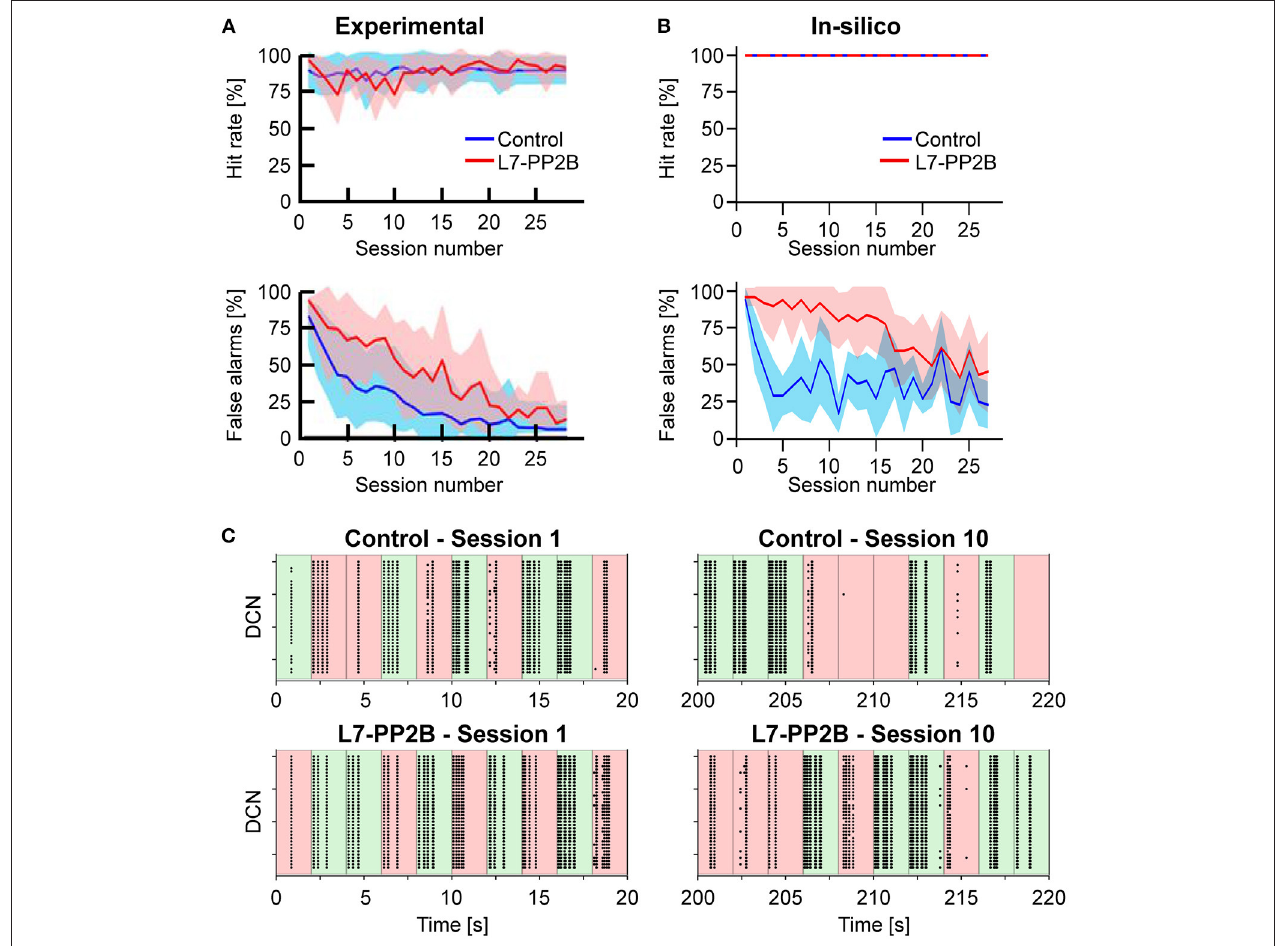
FIGURE 5 | (A) Learning curves recorded in the experiment performed by Rahmati et al. (2014). The upper row shows the Hit rate (i.e., the percentage of correct responses in GO trials) along with sessions, where each session is composed of 10 trials. The lower row shows the False alarms (i.e., the percentage of incorrect responses in NOGO trials) along with sessions. The blue and red curves show the mean values for control animals and knock-out (L7-PP2B) mice. Shaded areas show the standard deviation. (B) Learning curves recorded from the in-silico experiments (10 control and 10 knock-out models). Colors are the same as in (A) . (C) Spiking activity of the DCN neurons during GO (green) and NOGO (red) trials, in the first session (left column) and after 10 sessions of training (right column). The first row reports the activity of one Control simulation, while the second row reports one knock-out simulation. Each dot is a spike of one of the 36 DCN in the cerebellar network. The order of GO and NOGO trials is randomized for each session and simulation, but all sessions have 5 GO and 5 NOGO